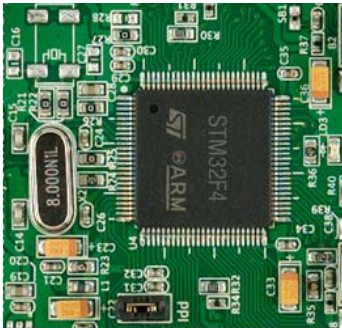
Figure 3. The processor used in the embedded